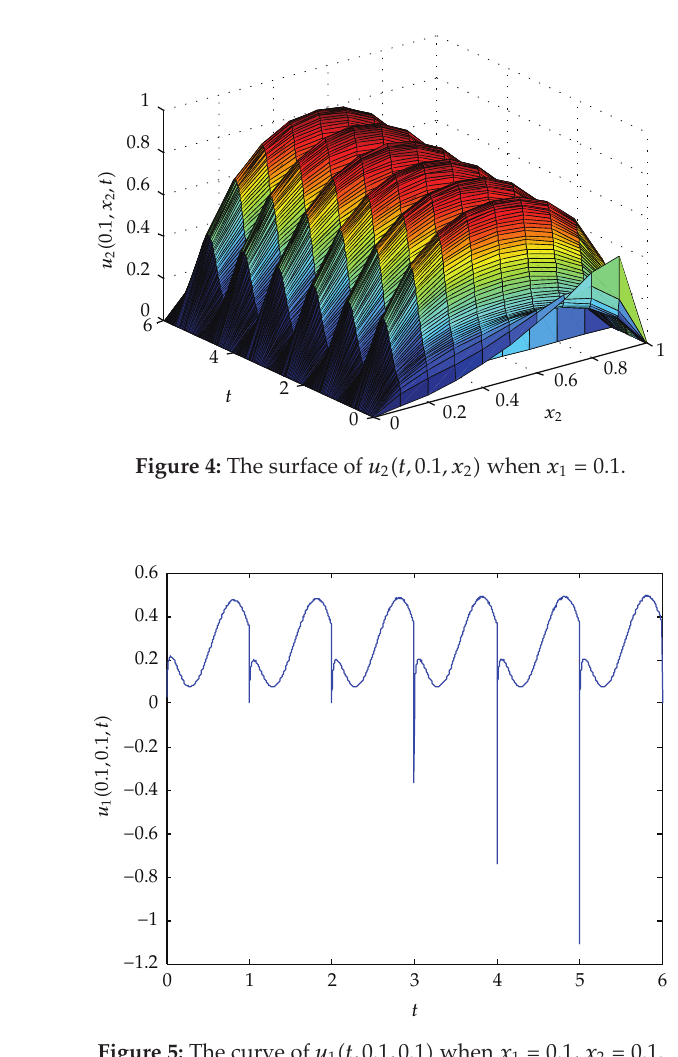
Figure 5: The curve of u 1 (cid:3) t, 0 . 1 , 0 . 1 (cid:4) when x 1 (cid:8) 0 . 1, x 2 (cid:8) 0 .